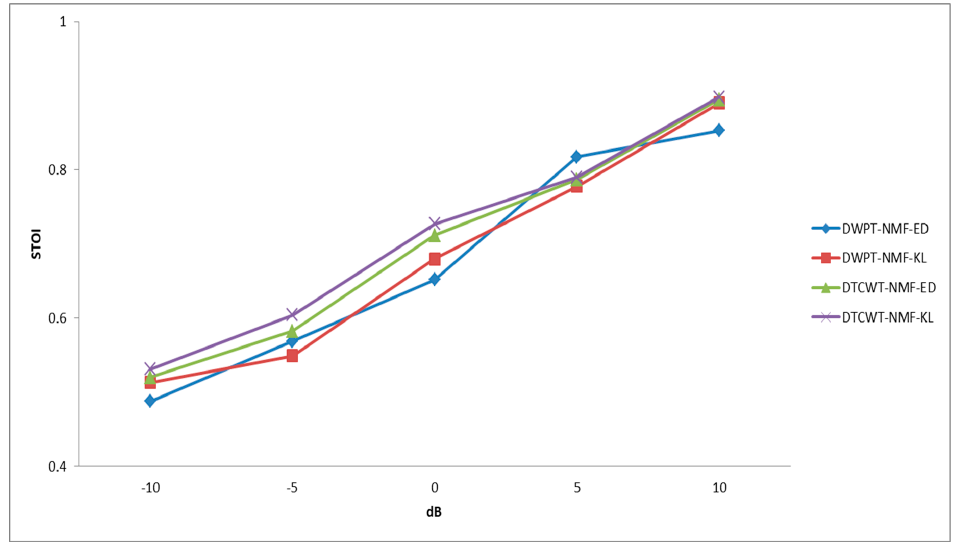
Figure 3. Comparison between DTCWT-NMF and DWPT-NMF methods with ED and KL.